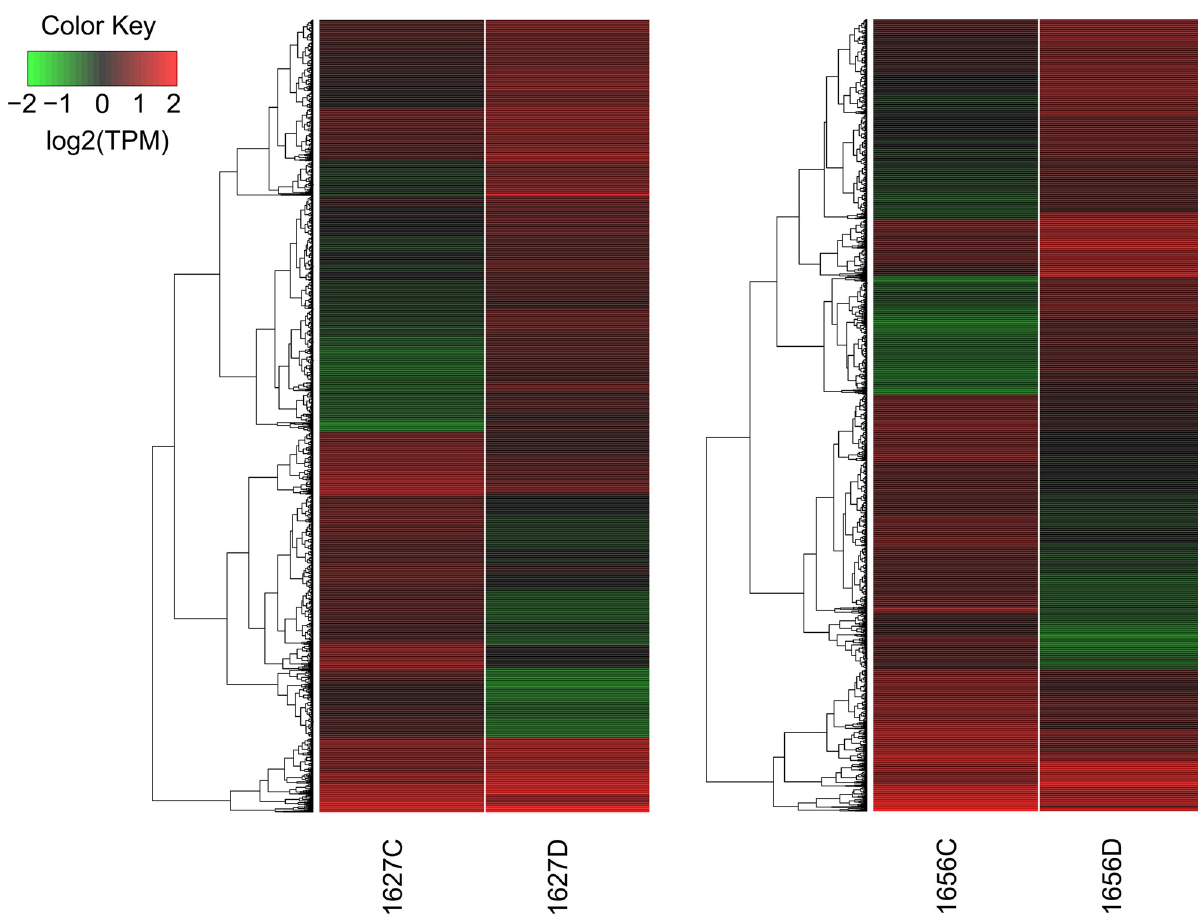
Fig 3. Differential expression pattern showed by drought sensitive (1627) and tolerant (1656) onion genotypes under drought stress.